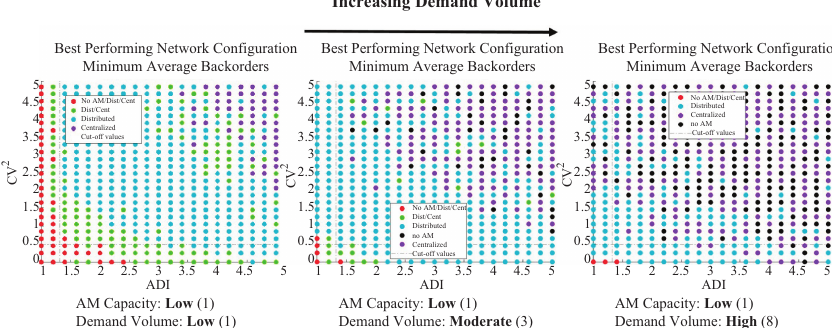
Figure 14. (Color online) Comparisonofnetwork configuration performance for a fixed AM machine capacity of 1 part per period and increasing